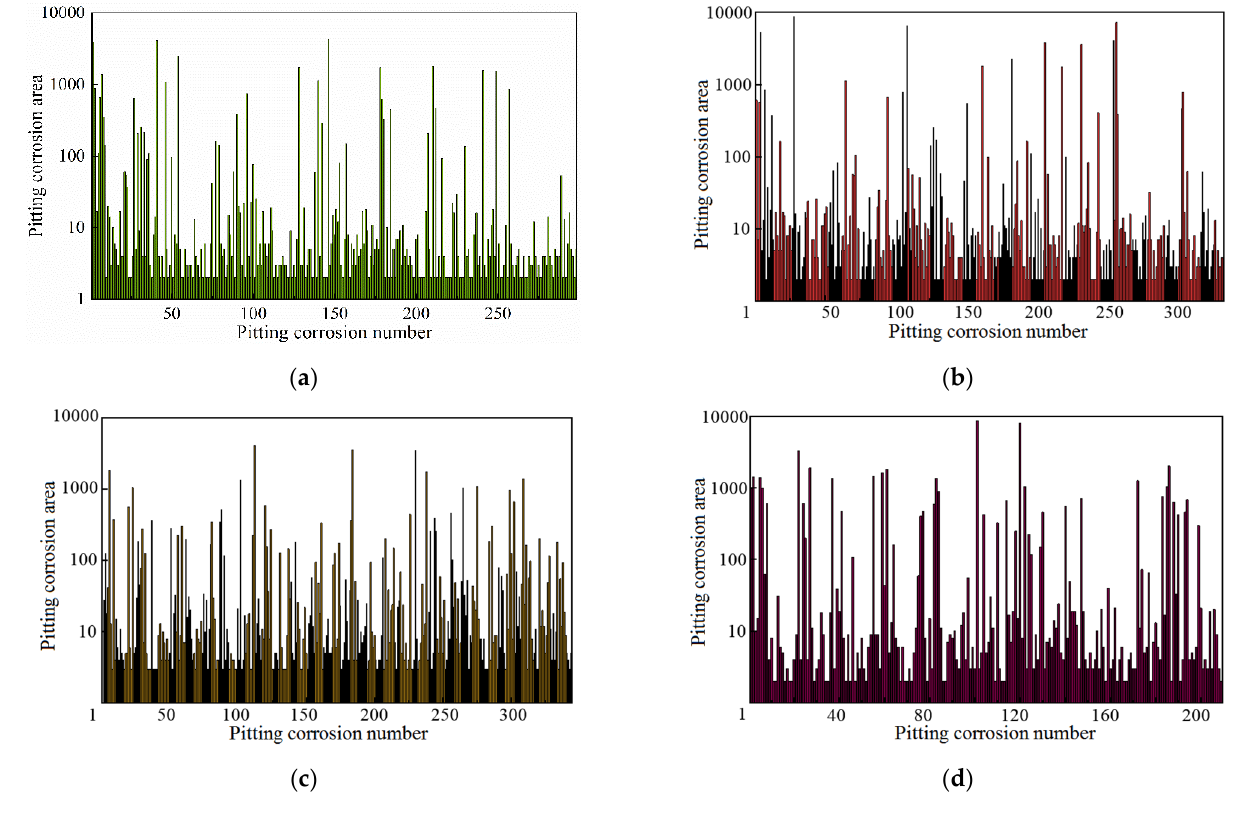
Figure 5. Pitting area distribution on sample surface at different Cl − concentrations: ( a ) 50% [Cl − ] Std ;